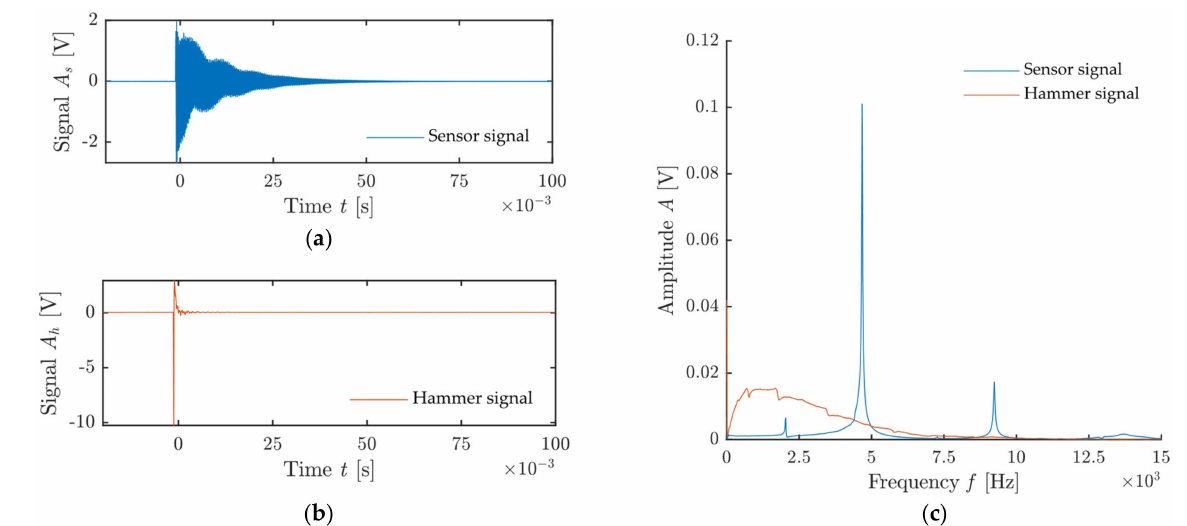
Figure 3. Comparison of sensor and hammer signals and their frequency spectrum: ( a ) Signal of receiving sensor attached to test specimen; ( b ) signal of hammer sensor; ( c ) frequency spectrum of both